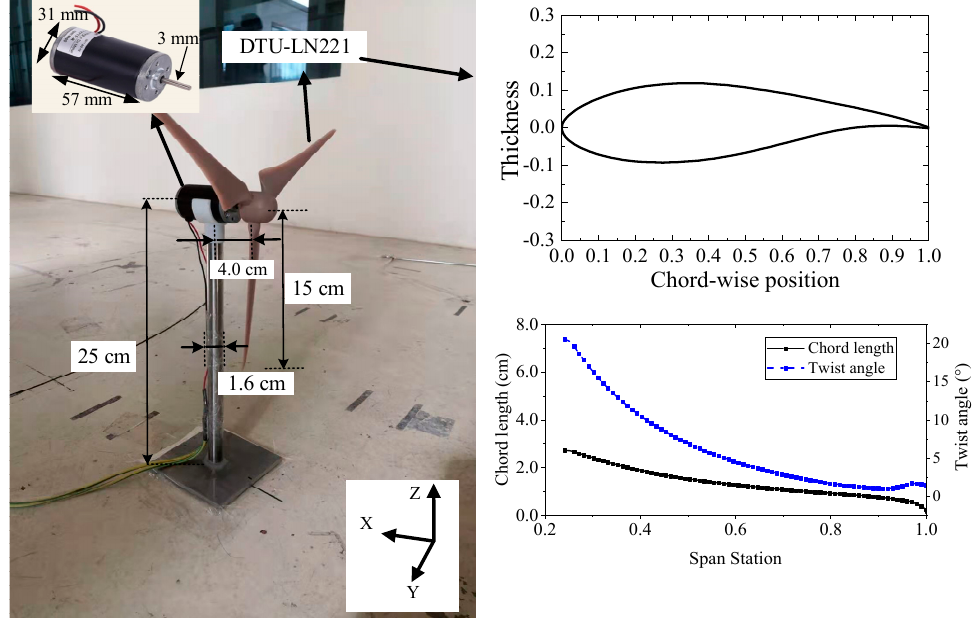
Figure 1. Arrangement of the test turbine and the parameters.